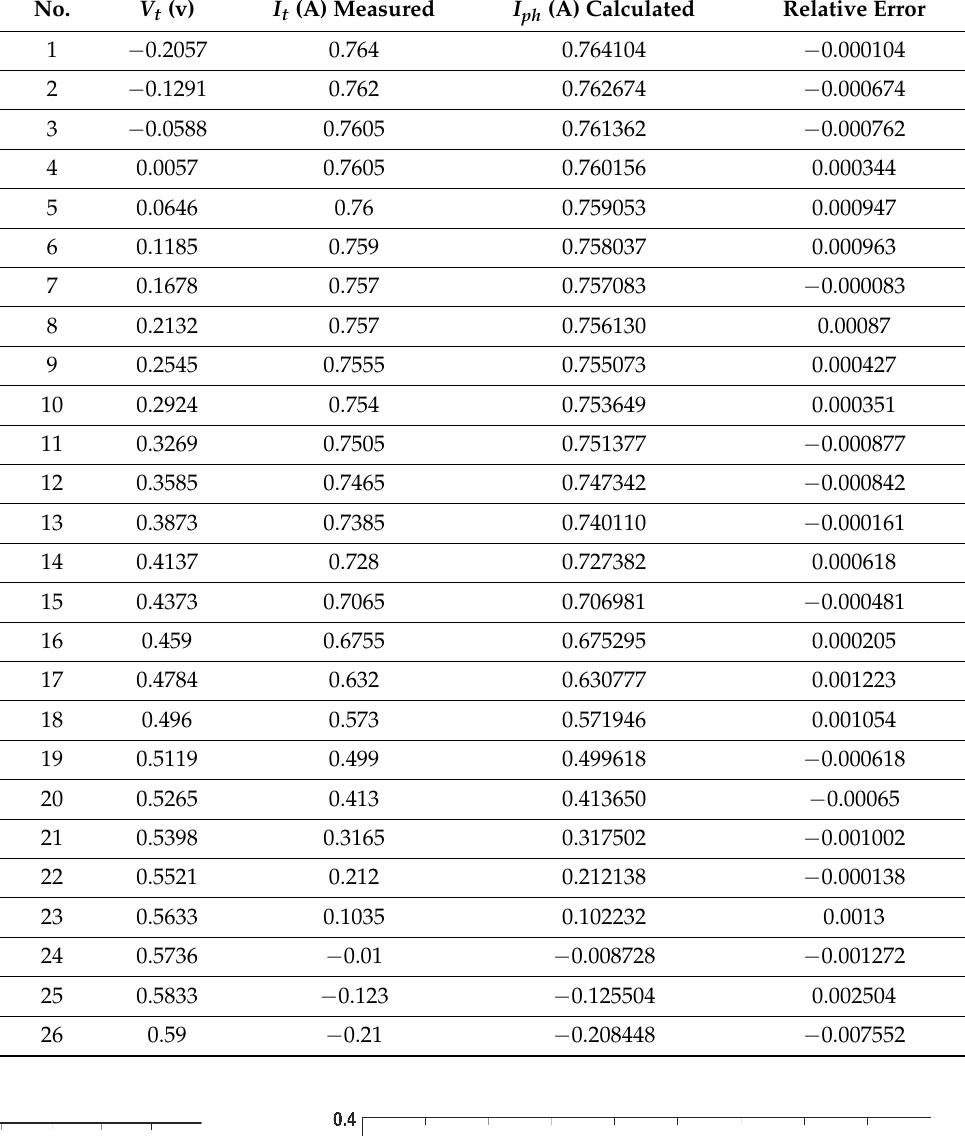
Table 5. The relative error for 26 measurements (single diode) with CEHO.